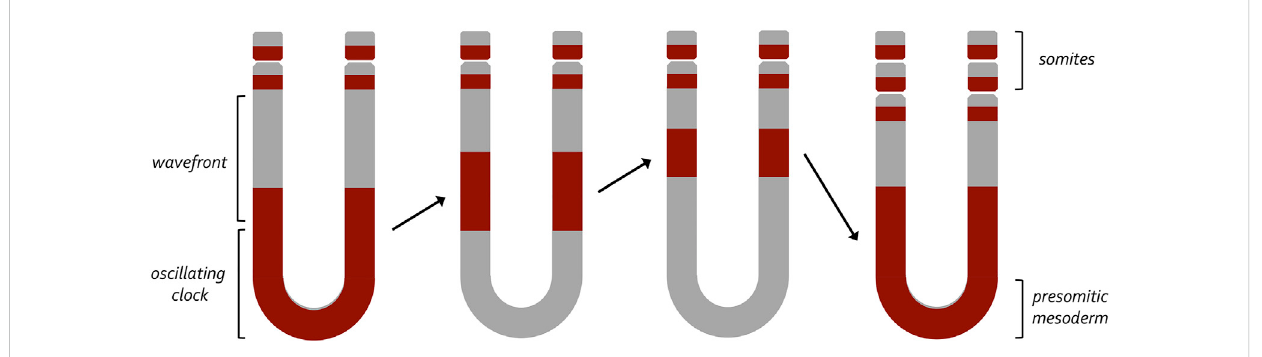
FIGURE 4 A clock and wavefront model for the generation of vertebrate somites. This model, developed by Johnathan Cooke and Erick Christopher Zeeman, proposedatwo-componentmechanismthatwouldaccountfortheperiodicemergenceofvertebratesomites.Atitscoreitproposesthatawavefrontof maturation (i.e., gene expression) transforms populations of undifferentiated cells into a pair of somites at periodic intervals. These periodic waves are triggered by an internal oscillator within the pre-somitic mesoderm (clock). Initially, it was thought that a similar internal oscillator could participate in the production of column of ommatidia within the fl y eye. The variable rate at which these columns are now known to be produced suggests that an internal clock does not exist within the fl y eye imaginal